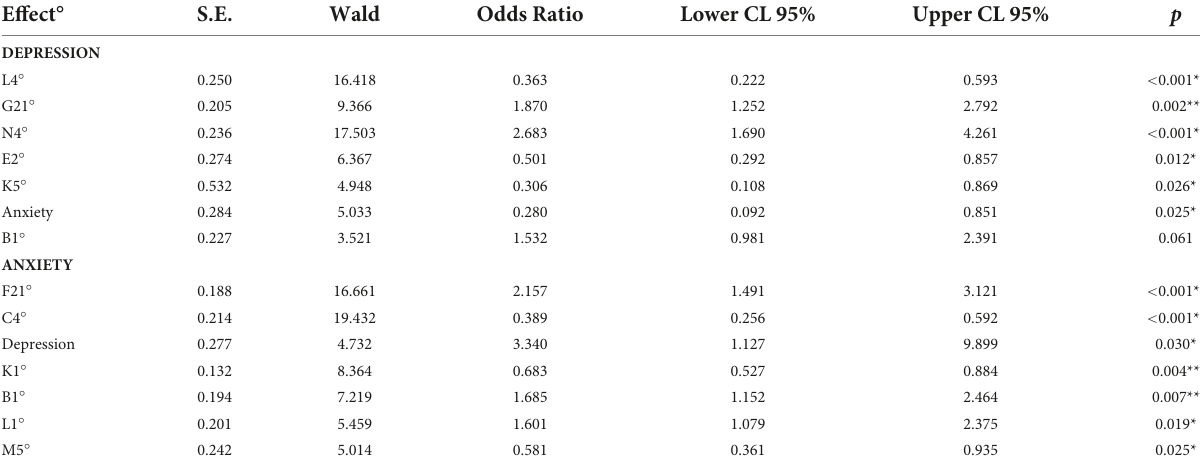
TABLE 3 Factors associated with clinical depression and anxiety during